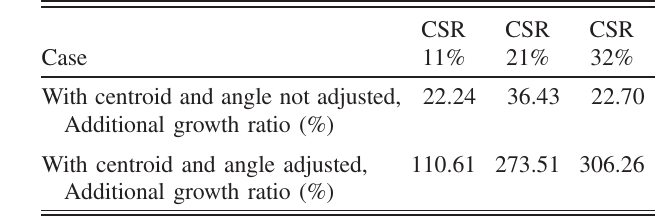
TABLE VII. Enhancement of the head-erosion effect due to the CSR calculated using the maximum emittance along the beam